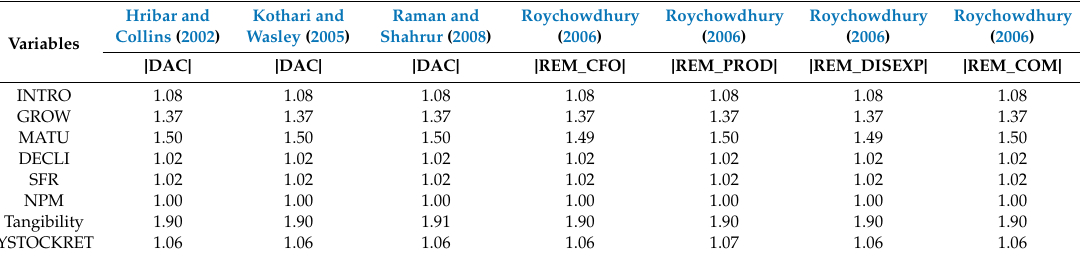
Table 5. Variance Inflation Factor (VIF)